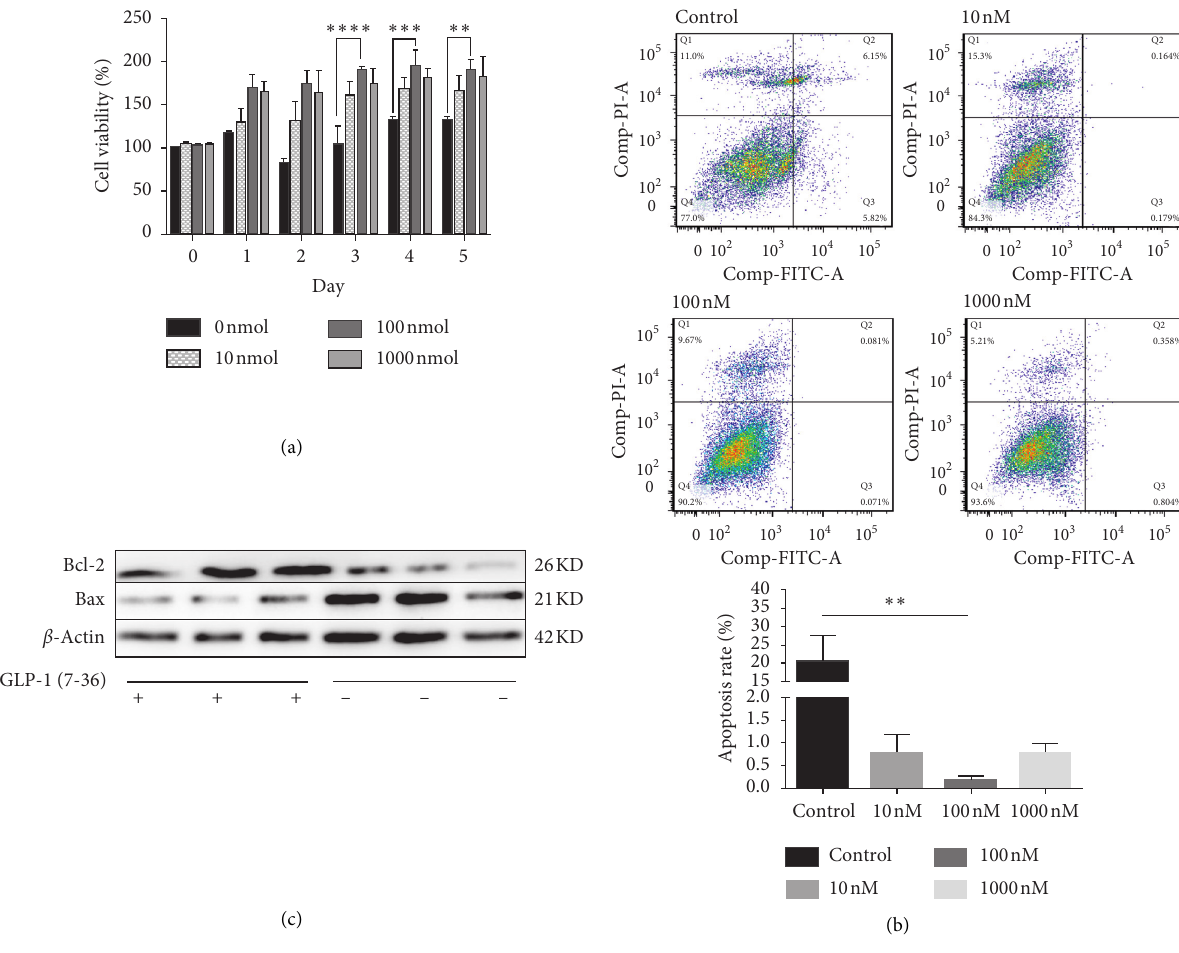
Figure 3: Proliferation and antiapoptosis of granulosa cells of PCOS mice were promoted by GLP-1 (7-36) in vitro . (a) GCs were isolated from the ovaries of PCOS model mice (day 54 of life) and treated with increasing doses of GLP-1 (7-36) (0, 10, 100, and 1000nM). Cell viability was measured by CCK-8 assay. (b) Flow cytometry Annexin V-FITC/PI double staining was used to detect the apoptotic rate of PCOS MGCs in control group and GLP-1 (7-36) (10 nM, 100nM, and 1000nM) treated for 48 hours. (c) Bcl-2, bax, and beta-actin were detected using their specific antibodies by the Western blot analysis for the PCOS MGCs with or without 100nM GLP-1 (7-36) interference for 48 hours. Results are expressed in at least three separate experiments. ∗ P < 0 . 05, and ∗∗ P < 0 .